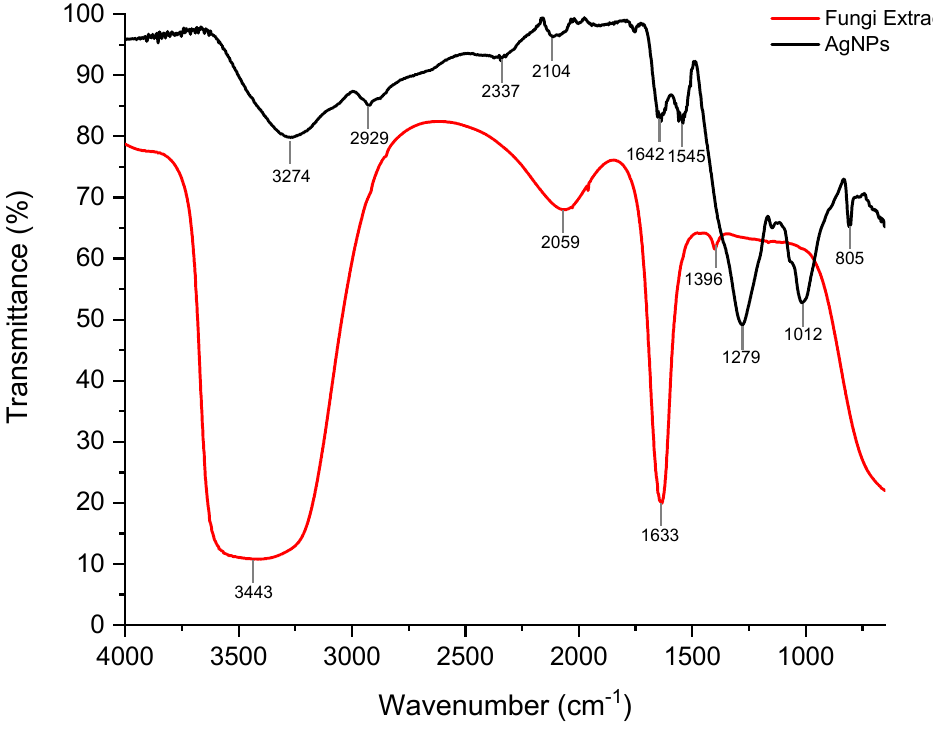
Figure 7. Fourier Transform Infrared Vibrational Spectroscopy (FTIR) spectrum showing band patterns of the aqueous extract of the fungus I. fumosorosea (red) and of AgNPs synthesized with the fungal extract (black).